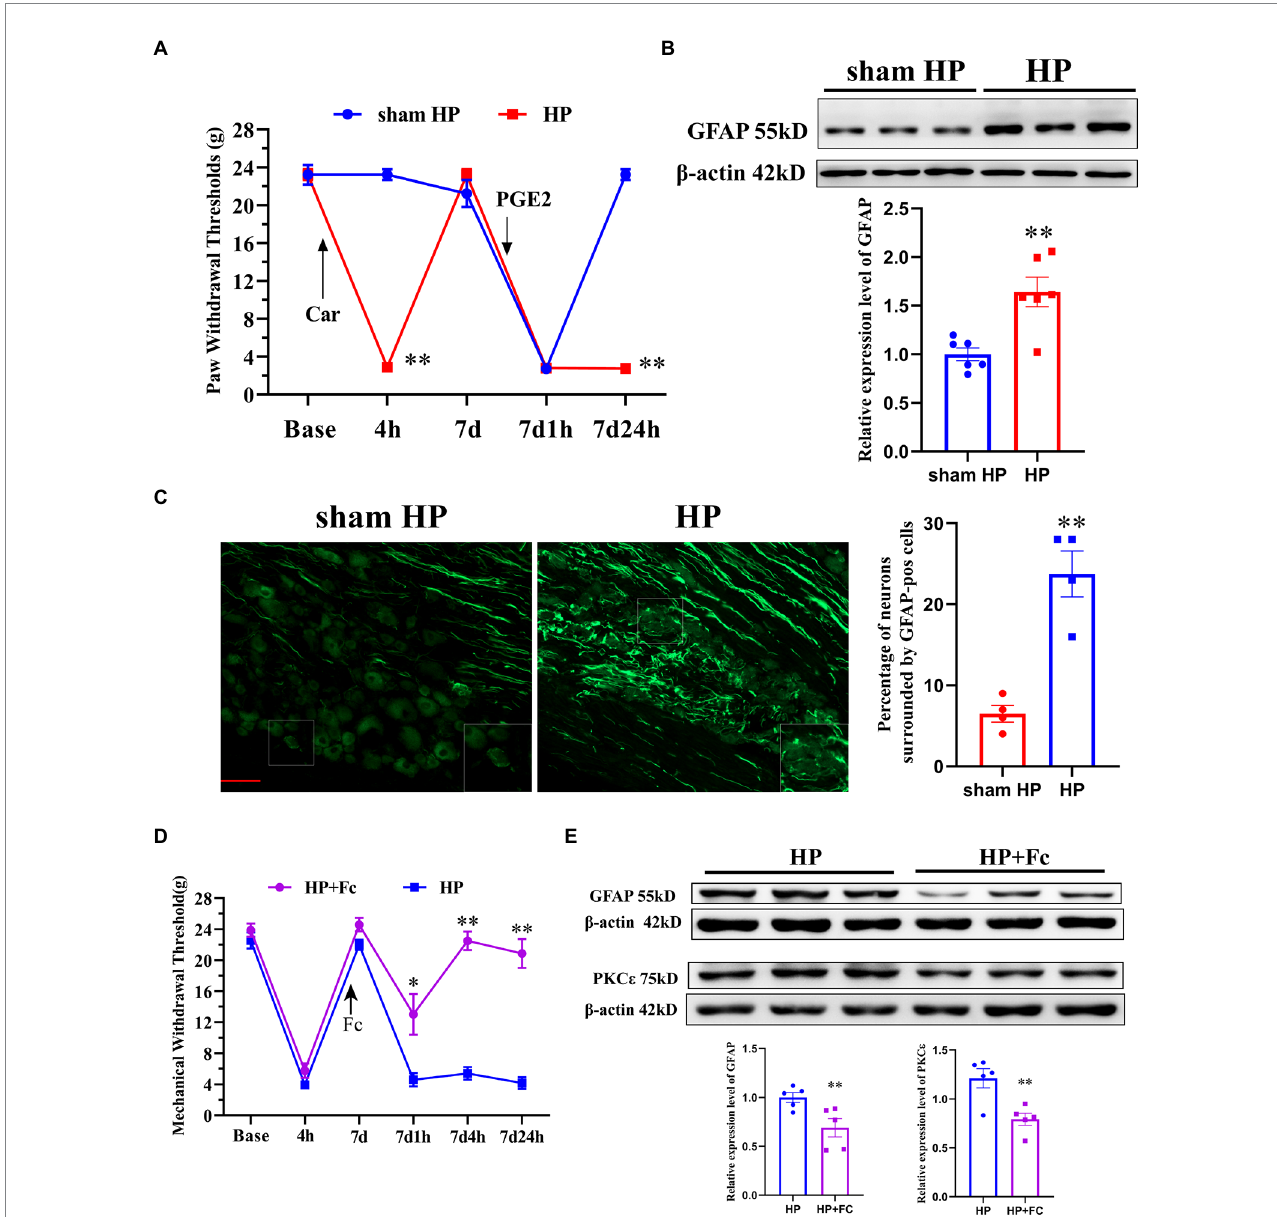
FIGURE 1 Induction of SGC reactivity plays a key role in the initiation of pain transition. (A) The mechanical withdrawal thresholds (MWTs) of rats that received Car (2%, 100 μ l/paw) and PGE2 (100 ng/25 μ l/paw) injections. n = 5 rats per group. (B) Quantification of the Western blot results and a representative Western blot showing GFAP protein expression levels in the DRG 24 h after PGE2 injection. (C) Representative images of GFAP-positive SGCs (the enlarged image is in the lower right corner) in the lumbar DRGs of HP model rats. Quantification of neurons surrounded by GFAP-positive SGCs the in L4–L5 DRGs. (D) Injection of Fc (an antagonist of SGC activation, 2 nmol, three times) into the L5 DRG before PGE2 injection produced analgesic effects in HP model rats. n = 6 rats per group. (E) Quantification of the Western blot results and a representative Western blot showing GFAP and PKC ε protein expression levels in the DRG 24 h after PGE2 injection. * p < 0.05, ** p <